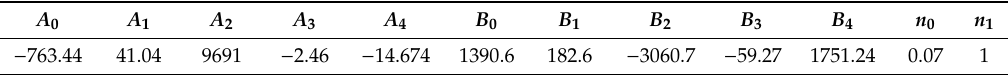
Table 3. Parameter A as a 2nd degree polynomial function of temperature and strain rate. A